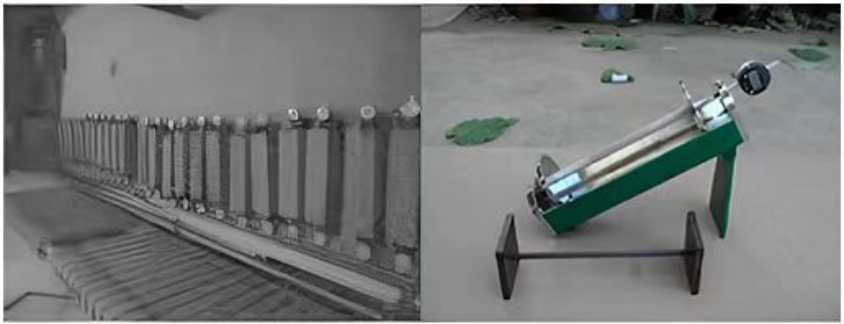
Figure 2. Experiment of dry shrinkage.